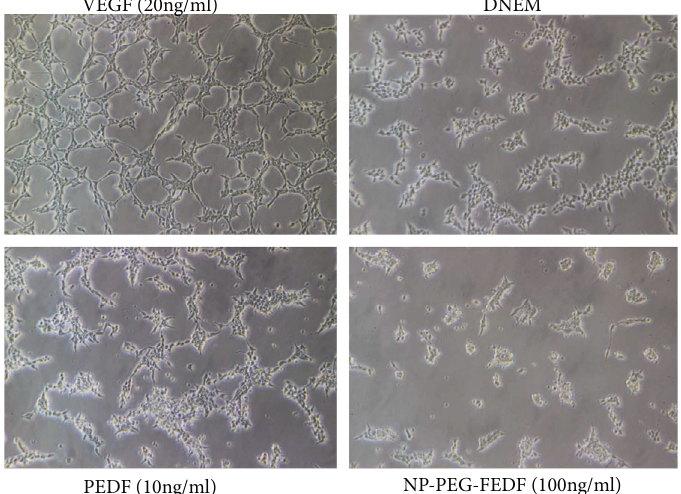
Figure 6: Statistical results of the percent wound closure (%) under di ff erent treatments. ∗ p < 0 : 05 .